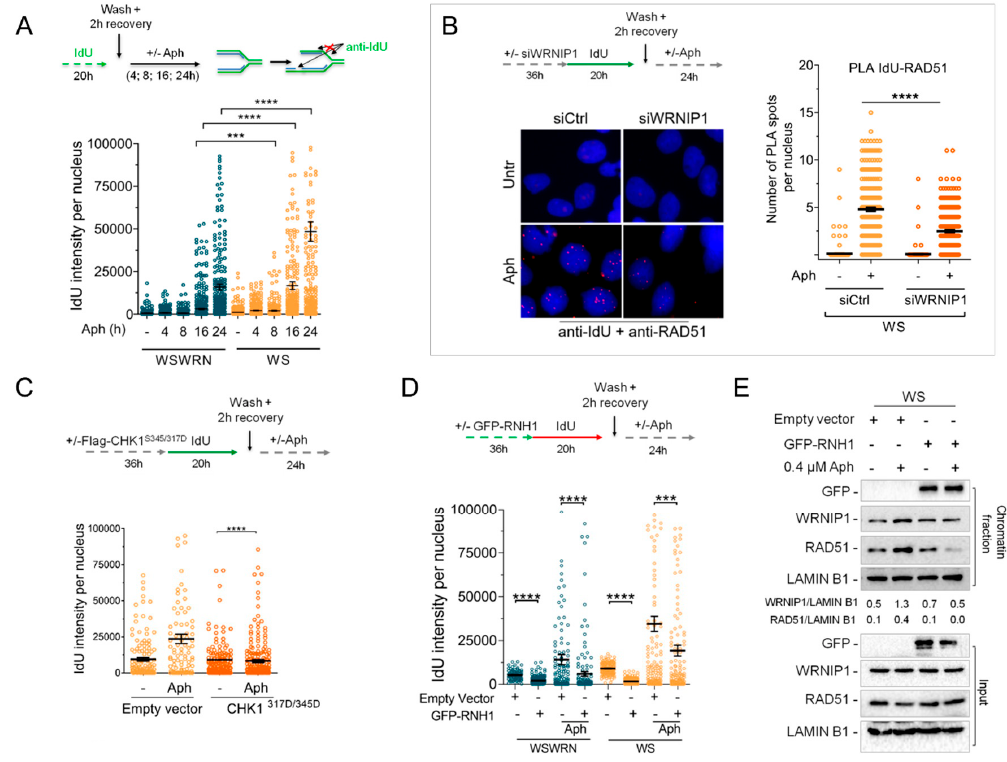
Figure 6. RAD51-ssDNA association requires WRNIP1 in WS cells upon MRS. ( A ) Detection of ssDNA by IF with an anti-BrdU/IdU antibody in WSWRN and WS cells treated with 0.4 µM Aph for different times as reported in the scheme. Graph shows the mean ± SE from three independent experiments; ( B ) Analysis of proximity between ssDNA (anti-BrdU/IdU antibody) and endogenous RAD51 (anti-RAD51 antibody) performed by in situ PLA assay in WS cells depleted of WRNIP1 and treated as reported in the scheme. PLA interaction is shown in red. Graph shows the number of PLA spots per nucleus; ( C ) Detection of ssDNA by IF with anti-BrdU/IdU antibody in WS cells transfected with an empty vector or a FLAG-tagged CHK1 317/345D and treated with 0.4 µM Aph. Graph shows the mean ± SE from three independent experiments; ( D ) Detection of ssDNA by IF with anti-BrdU/IdU antibody in WSWRN or WS cells treated as reported in the scheme after transfection with a plasmid expressing GFP-tagged RNaseH1. Graph shows the mean ± SE from three independent experiments; ( E ) WB analysis of chromatin binding of WRNIP1 and RAD51 in WS cells treated as in (D). Chromatin fractionation was performed as described in Figure 2A. The membrane was probed with the indicated antibodies. The normalized ratio of the chromatin-bound WRNIP1/LAMIN B1 or RAD51/LAMIN B1 are given.